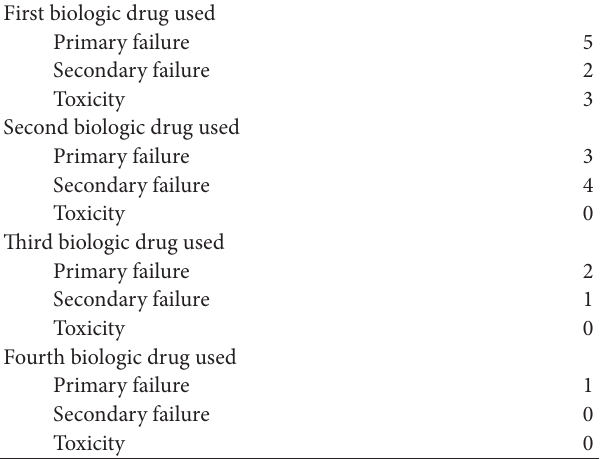
Table 3: Reasons for discontinuation of previous biologic